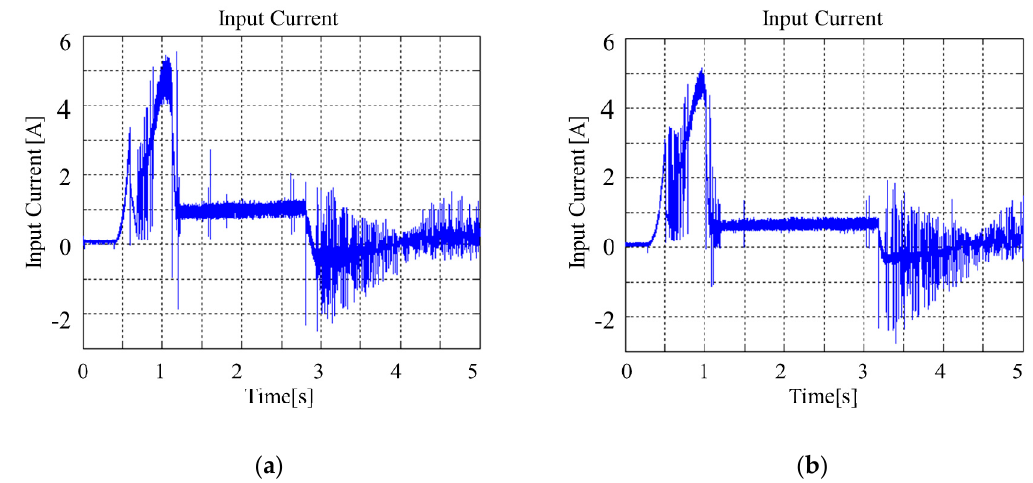
( b ) Figure 17. Experimental result of position control: ( a ) without MTPA and ( b ) with MTPA. To verify the effectiveness of the MTPA control method, Figure 18 shows the DC input current